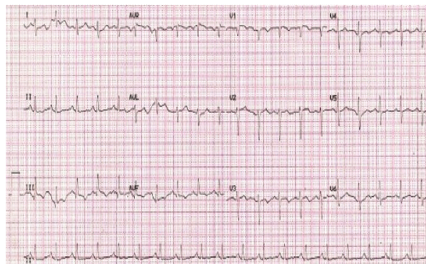
Figure 2: EKG with classic findings of S1Q3T3, an s wave in lead 1, q wave in lead 3, and T wave inversion in lead 3. Reference: EKG Electrophysiology Library of Dr. Johnson